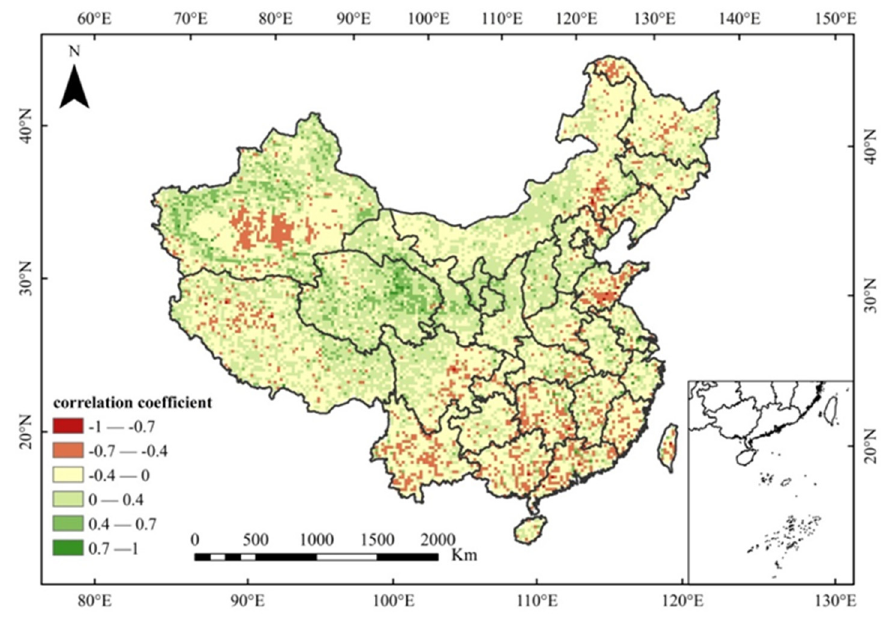
Figure 11. Correlation between annual TCO concentration and vegetation coverage.